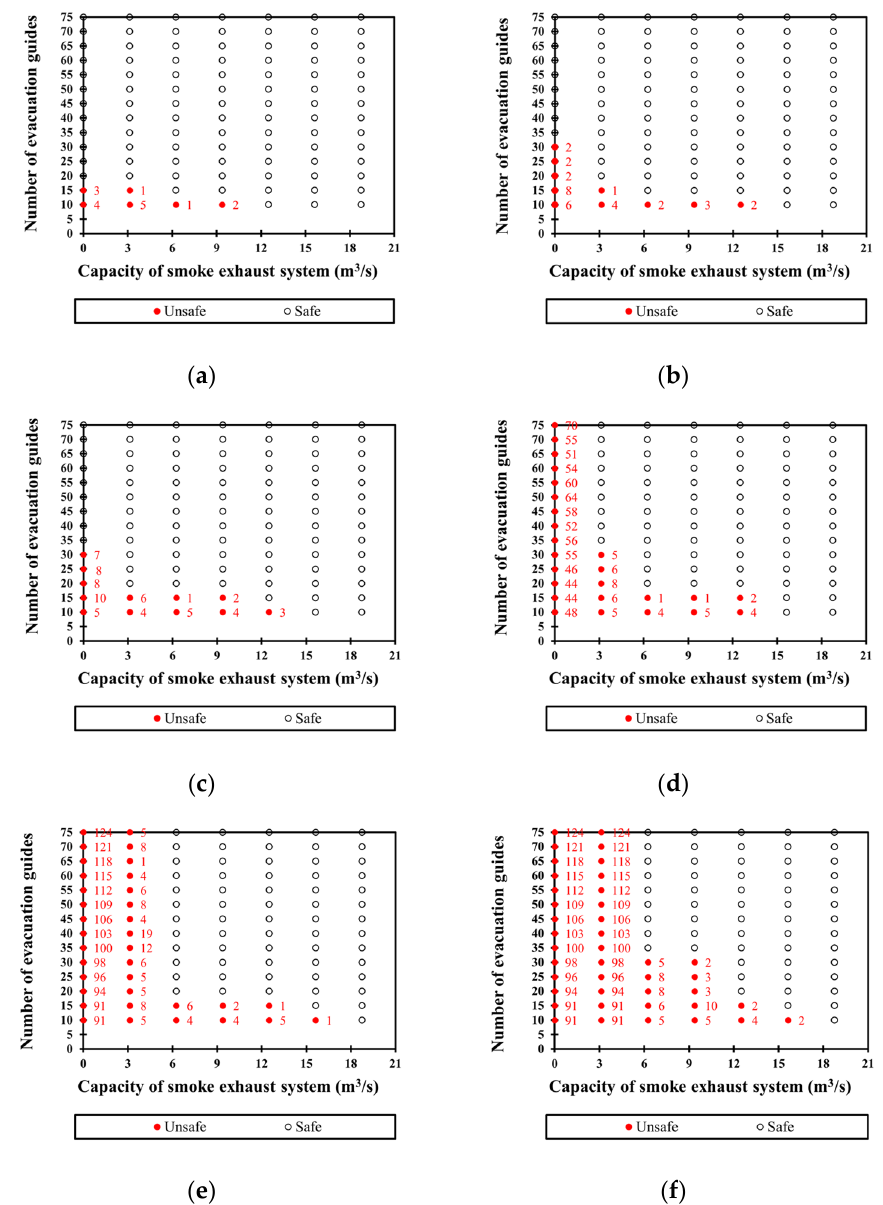
Figure 8. ( a ) Egress delay time 0; ( b ) egress delay time 60; ( c ) egress delay time 120; ( d ) egress delay time 180; ( e ) egress delay time 240; ( f ) egress delay time 300. time 180; ( e ) egress delay time 240; ( f ) egress delay time